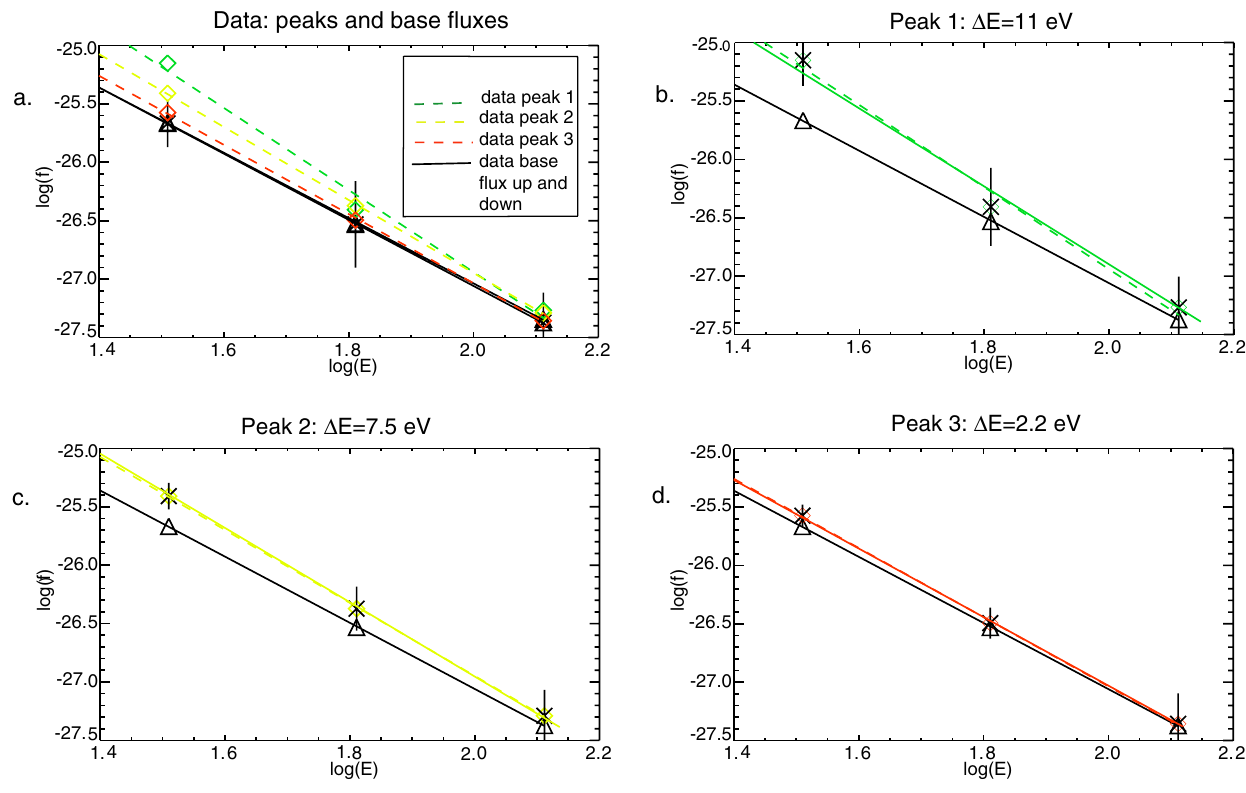
Fig. 8. Peaks in the downward differential electron energy flux data from the FAST satellite (dashed least-squares regression lines) compare well to the theoretical energy shift 1E that electrons would have after travelling through a region of localised parallel electric field (solid colour lines) for a power law energy distribution. Panel (a) shows data points for each peak in the signal, with the log of the phase space density plotted against the log of the electron energy, with the associated least-squares regression line (dashed lines). Uncertainty in the base flux data points (black triangles), due to the signal noise amplitude, are shown as error bars on panel (a). Panels (b)–(d) show the phase space density expected by shifting the power law particle distribution from the base level (black solid line) by the 1E displayed above each panel (solid coloured lines). Uncertainty in the peak phase space density data points (coloured diamonds), are shown on panels (b), (c), and (d) for peaks 1, 2 and 3,